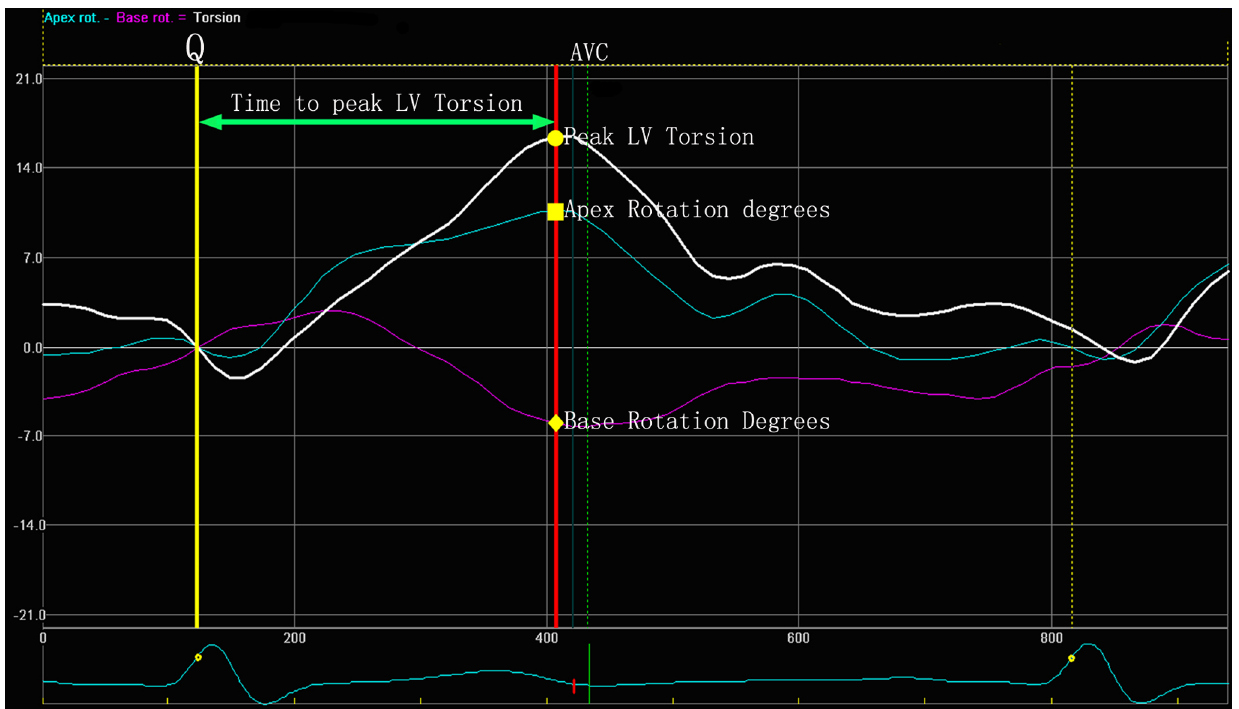
Figure 1. The yellow line means onset of QRS wave, the point of intersection of the red line and the white line means the peak LV torsion; The point of intersection of the red line and the purple line means the rotational degrees in the basal plane at the peak LV torsion; The point of intersection of the red line and the blue line means the rotational degrees in the apical plane at the peak LV torsion.